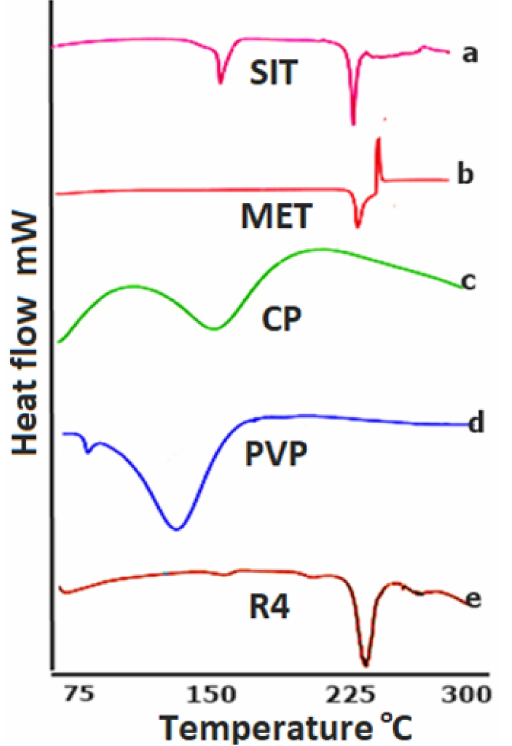
Figure 2. DSC thermogram of ( a ) sitagliptin phosphate monohydrate, ( b ) metformin hydrochloride,